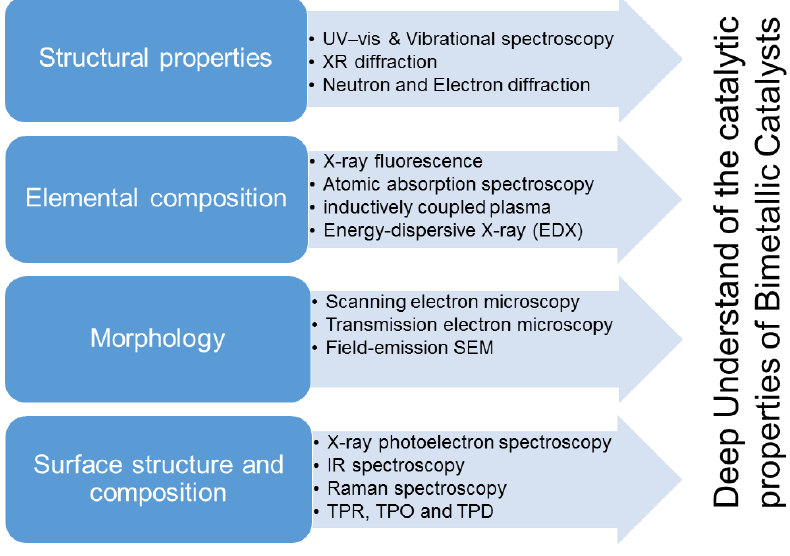
Figure 3. Summary of some selected characterization methods of bimetallic catalyst.